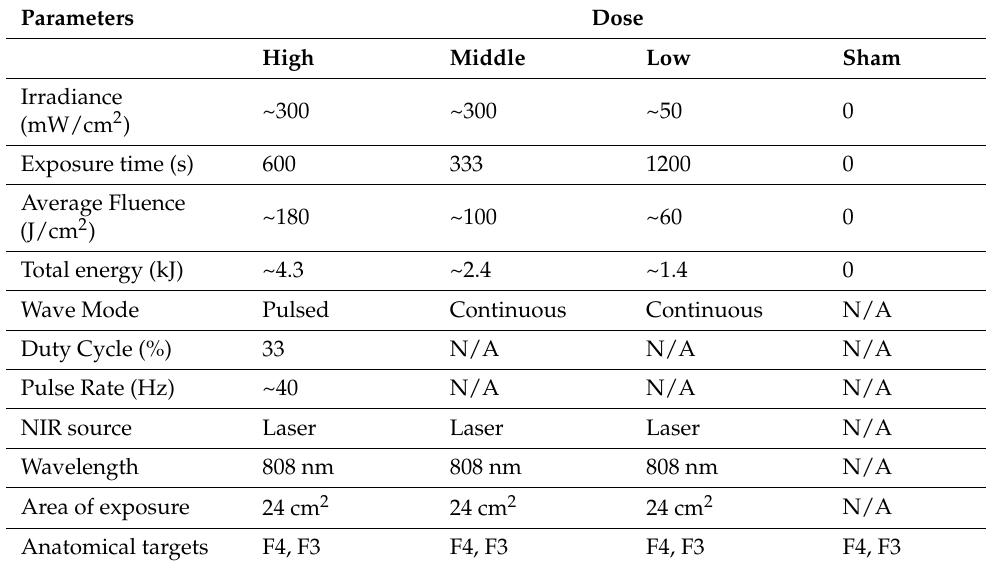
Table 2. Parameters of the four tPBM irradiance